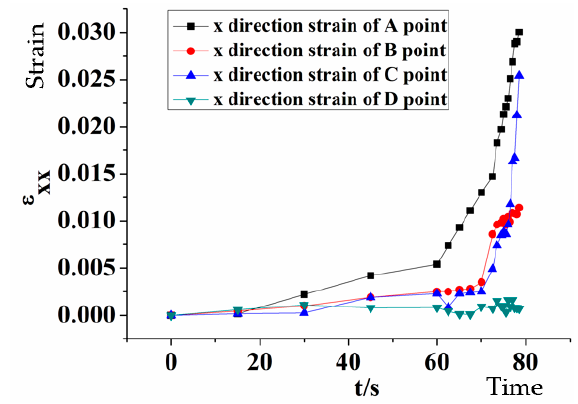
Figure 13. Strain–time profile along the x-direction (loading rate = 0.3 MPa/s).